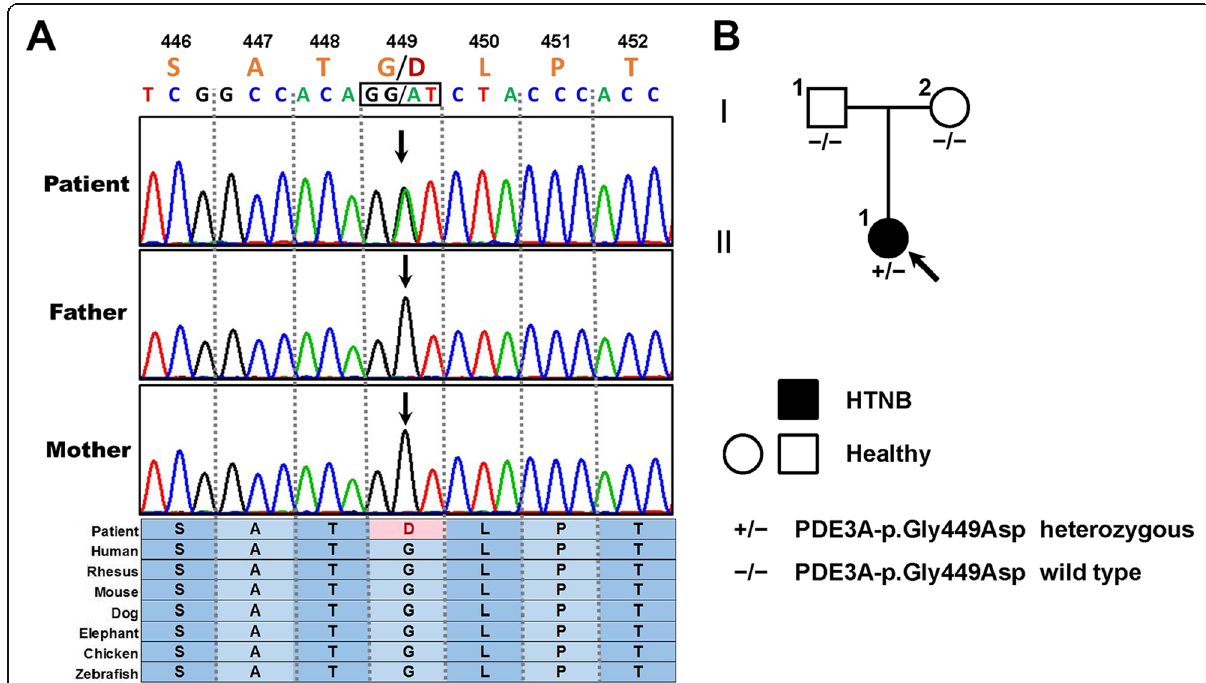
Fig. 2 The pathogenic variant and pedigree description. a Sanger sequencing of the family. Coloured blocks show the evolutionary conservation of the cluster across multiple species. b The family tree of the HTNB pedigree. Males and females are indicated by squares and circles, respectively. The filled symbol represents the HTNB-affected individual. The arrow shows the proband. +/ − represents the heterozygous PDE3A p.Gly449Asp variant. − / − represents the wild type